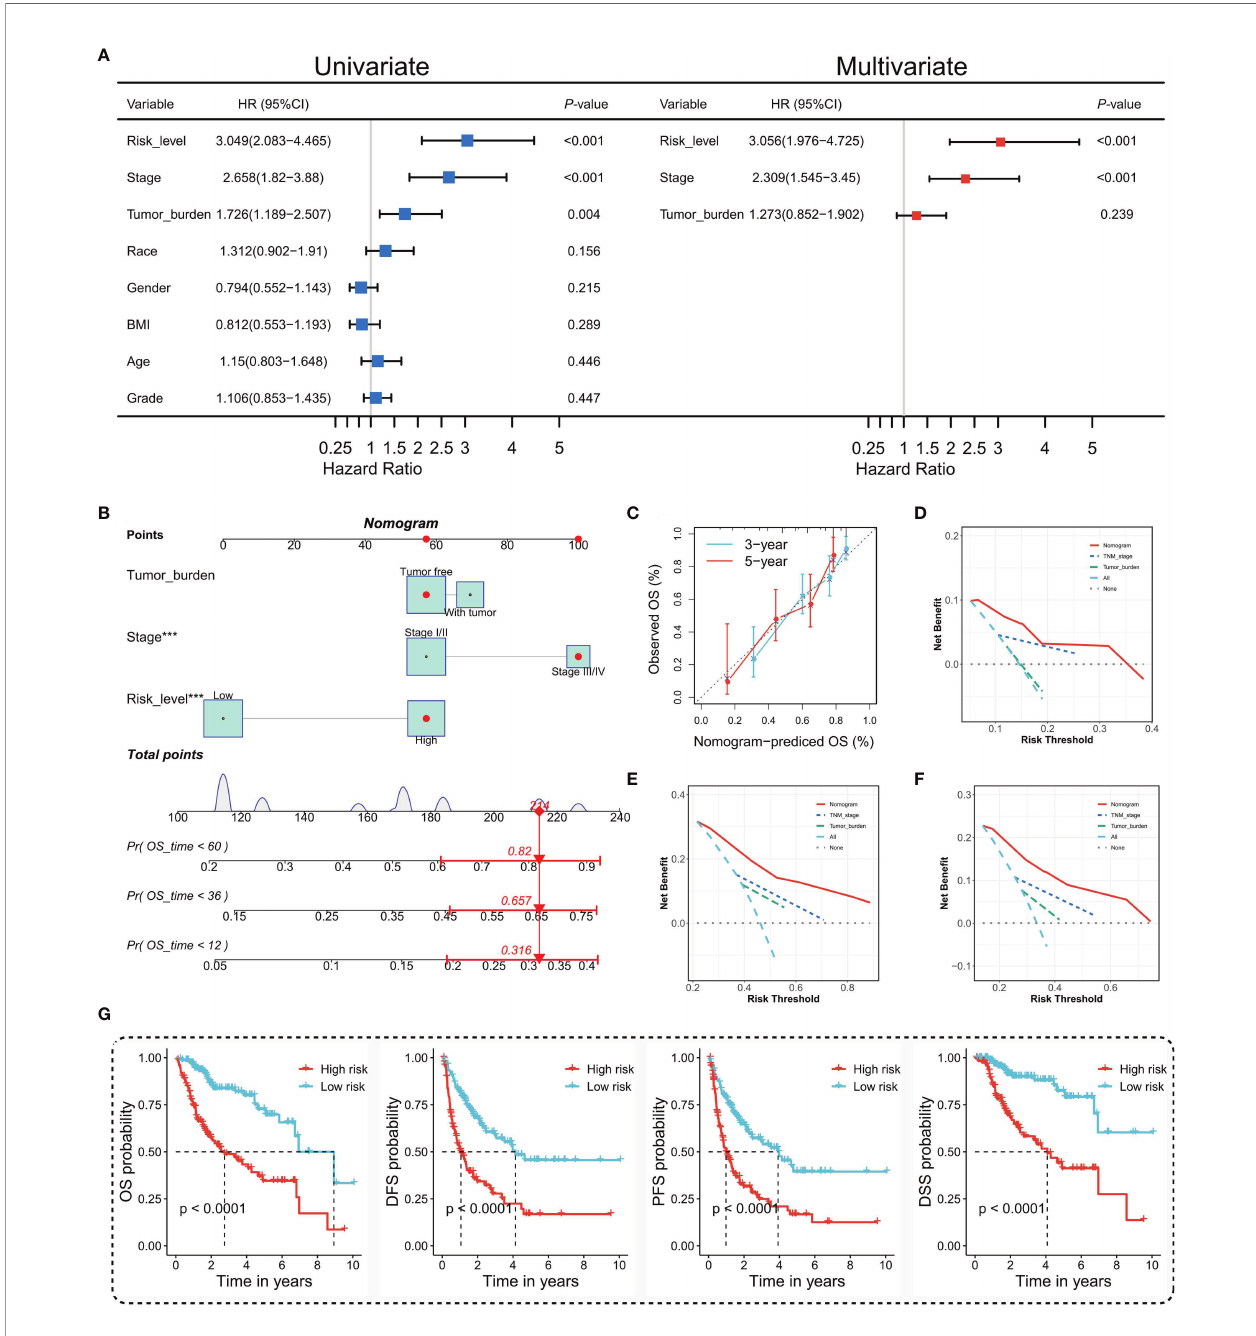
FIGURE 5 | Construction and evaluation of the TIPRGPI-integrated nomogram. (A) Univariate and multivariate analyses of the clinical traits and TIPRGPI for the OS. (B) Nomogram for predicting the probability of 1-, 3-, and 5-year overall survival in HCC. (C) The calibration plots of the nomogram predicting the probability of the 3- and 5-year OS. (D – F) Decision curves showing the comparison of net bene fi ts of the nomogram, TNM stage, tumor burden for 1-year (D) , 3-year (E) , and 5-year (F) OS. (G) Kaplan-Meier survival analysis of the integrated nomogram for OS, DFS, PFS, and DSS of HCC. ***P <